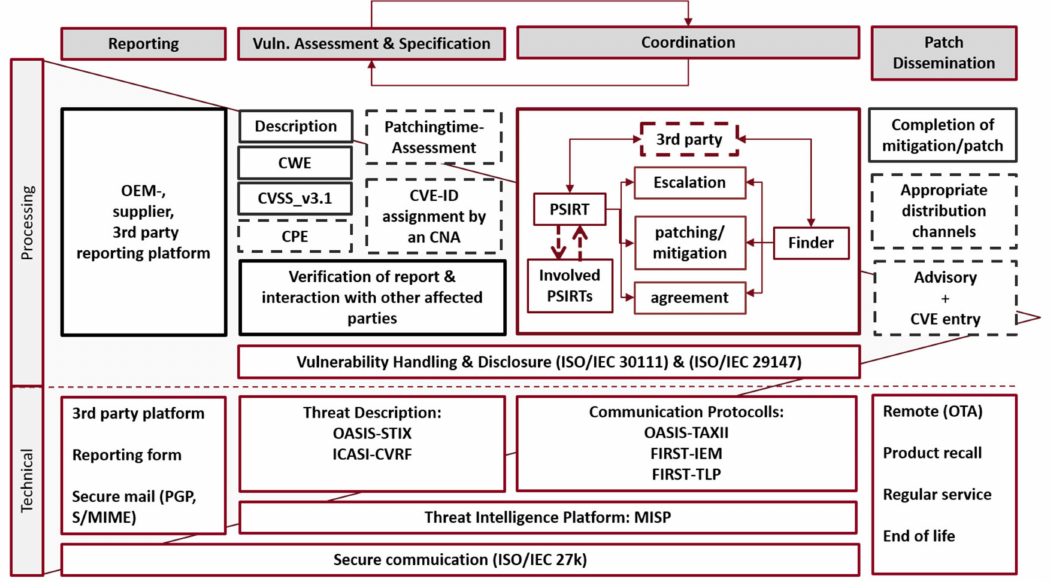
Figure 2. Overview of the phases of automotive vulnerability disclosure from a process and technical